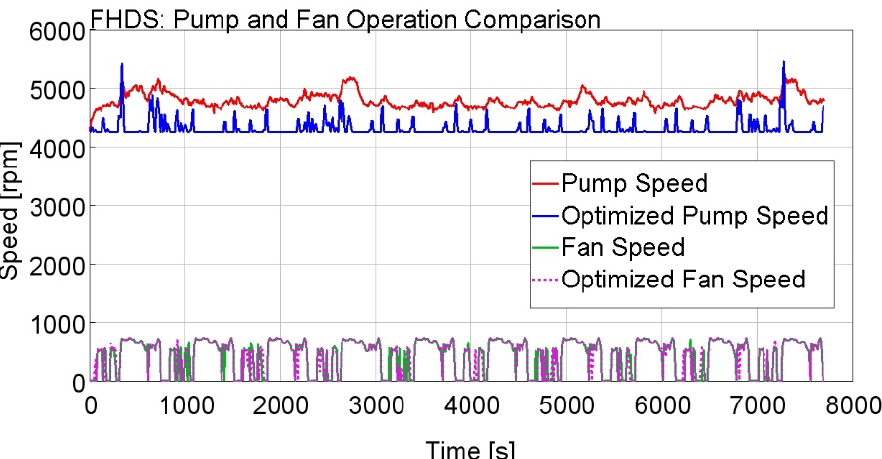
Figure 19. Control strategy comparison for single e-motor on FHDS driving cycle: coolant pump speed (top); radiator fan speed (bottom).